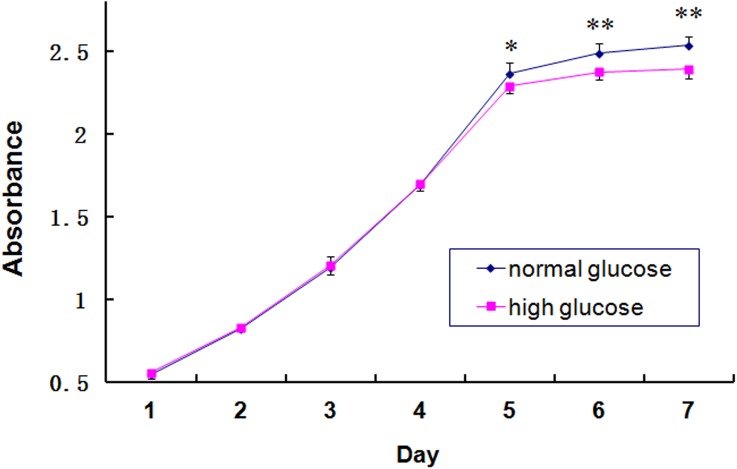
KSC growth curves after culturing in normal-glucose or high-glucose medium.Growth curves for cells cultured in high-glucose or normal-glucose media were graphed based on the OD values at 450 nm. (*P < 0.05, **P < 0.01).